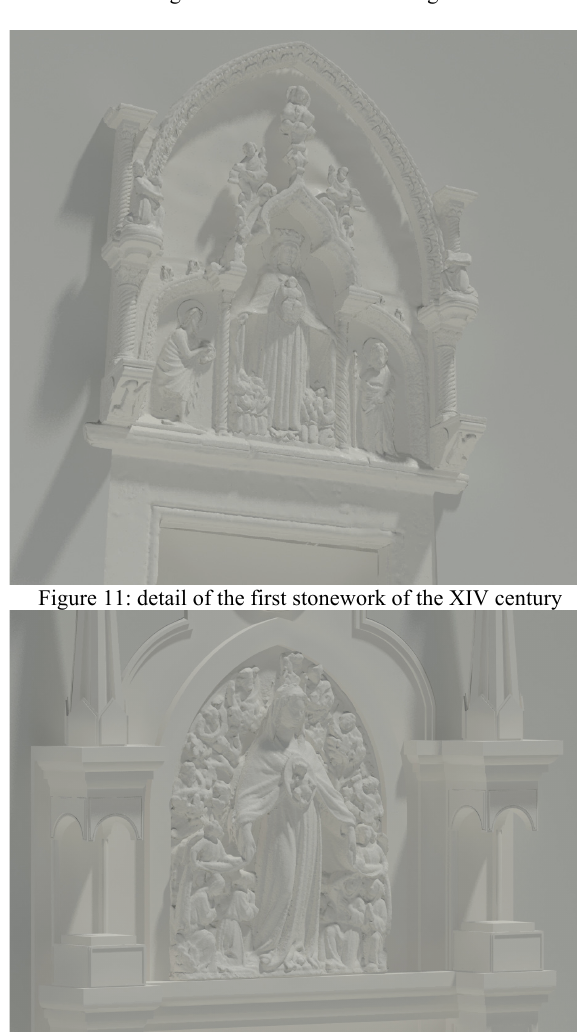
Figure 12: detail of the bas-relief over the entrance from the XVth to the XVIIth